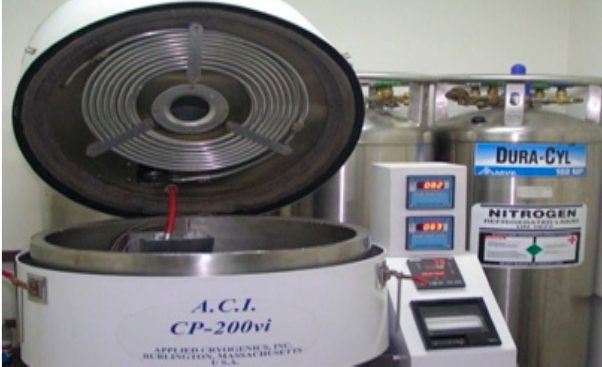
Figure 1. Cryogenic treatment processor equipment